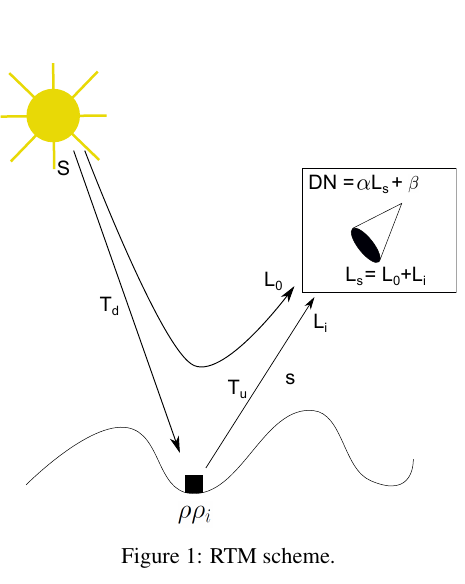
Figure 1: RTM scheme.